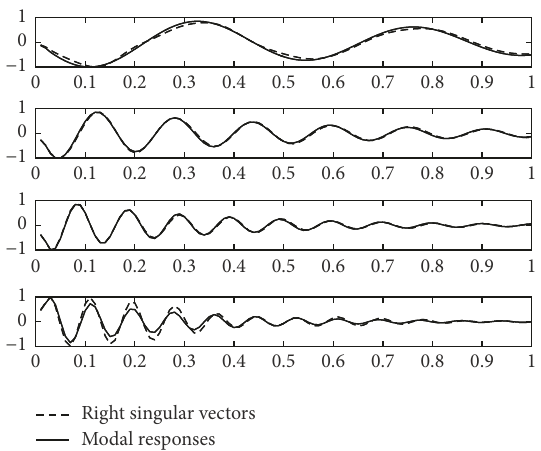
Figure 2: Comparison between right singular vectors, extracted by means of SVD, and modal responses of a 4-DOF share-type frame in free vibration, with reference to the example at Section 5.1.3. For an effective comparison, the vectors are both normalized to the maximum value and only the first 100 terms are